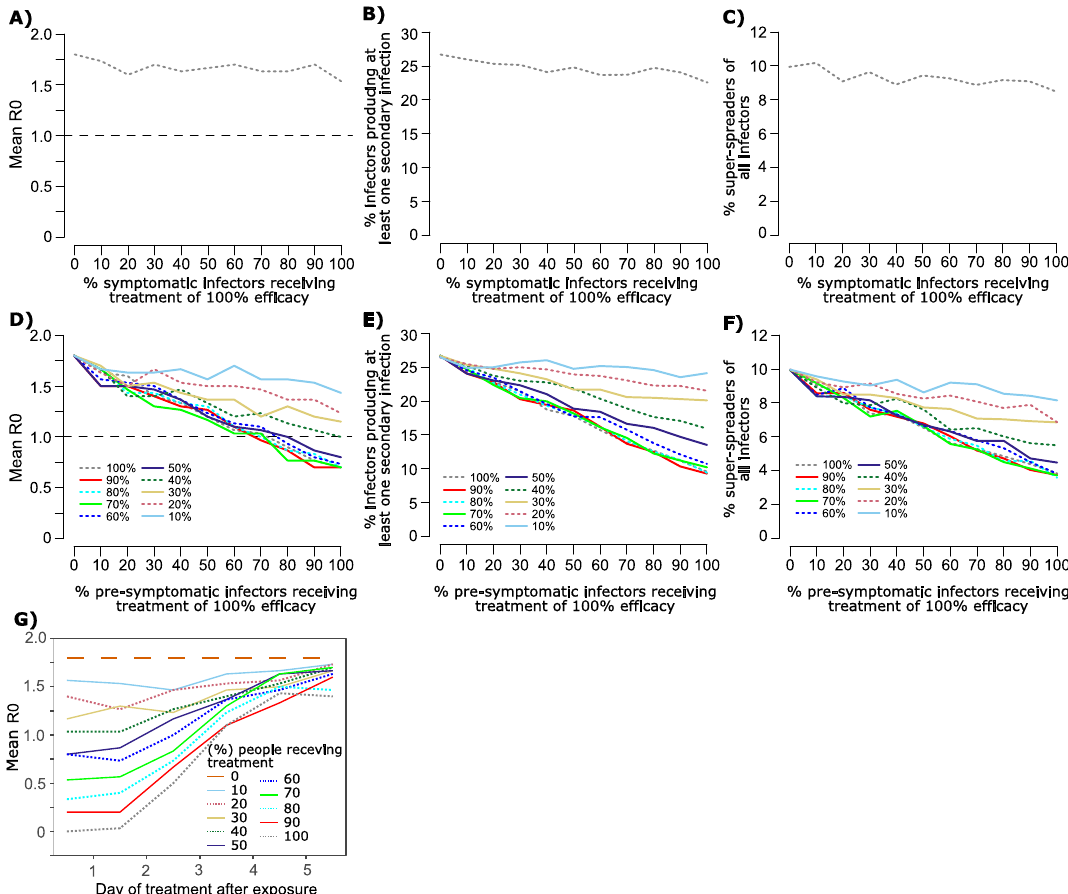
Figure 7. Projected impact of antiviral therapy on SARS-CoV-2 effective reproductive number (R e ). Each line in each panel is based on simulations of 3000 transmitters with varying daily exposure contacts. Panels ( A – C ) assume early symptomatic therapy (before peak viremia, within ~ 5 days after exposure) with 100% efficacy. Panels ( D – F ) assume post-exposure prophylaxis given during pre-symptomatic infection with different efficacies (colored lines). ( A and D ) Projected R e given different amounts of antiviral uptake in the population, ( B and E ) Projected percent of infected people who infect at least one person given different amounts of antiviral uptake in the population. ( C and F ) Projected percent of infected people who infect at least 5 people given different amounts of antiviral uptake in the population. ( G ) Projected impact of post-exposure prophylaxis on SARS-CoV-2 reproductive number according to the day of treatment relative to exposure with different percentages of infected individuals receiving antiviral